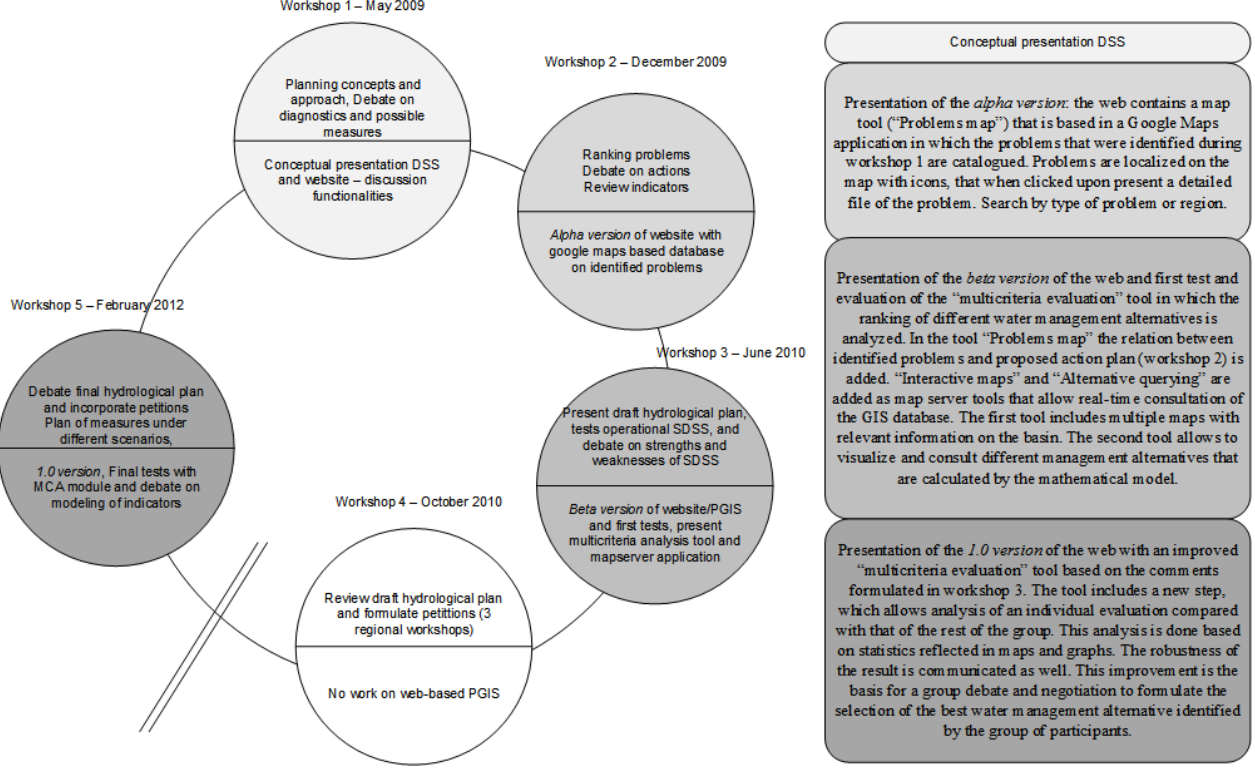
Fig. 3. Content of the five workshops and development of the website, with evolution of the SDSS and website in the bottom part of the circles and detailed on the right.